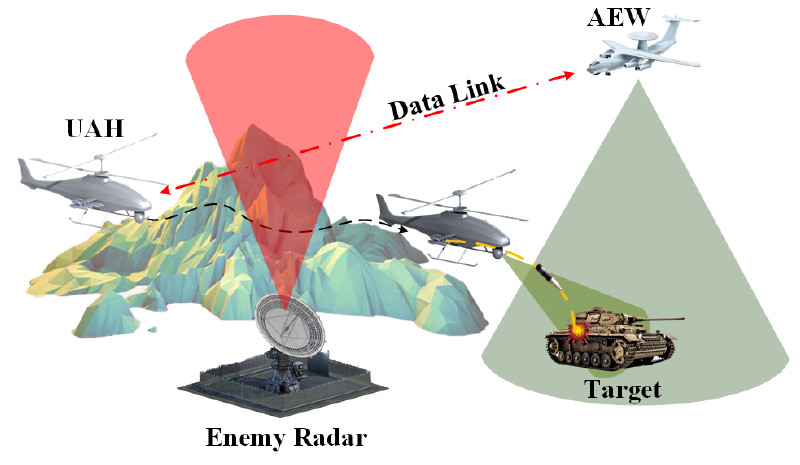
Figure 1. The attack process of UAH.